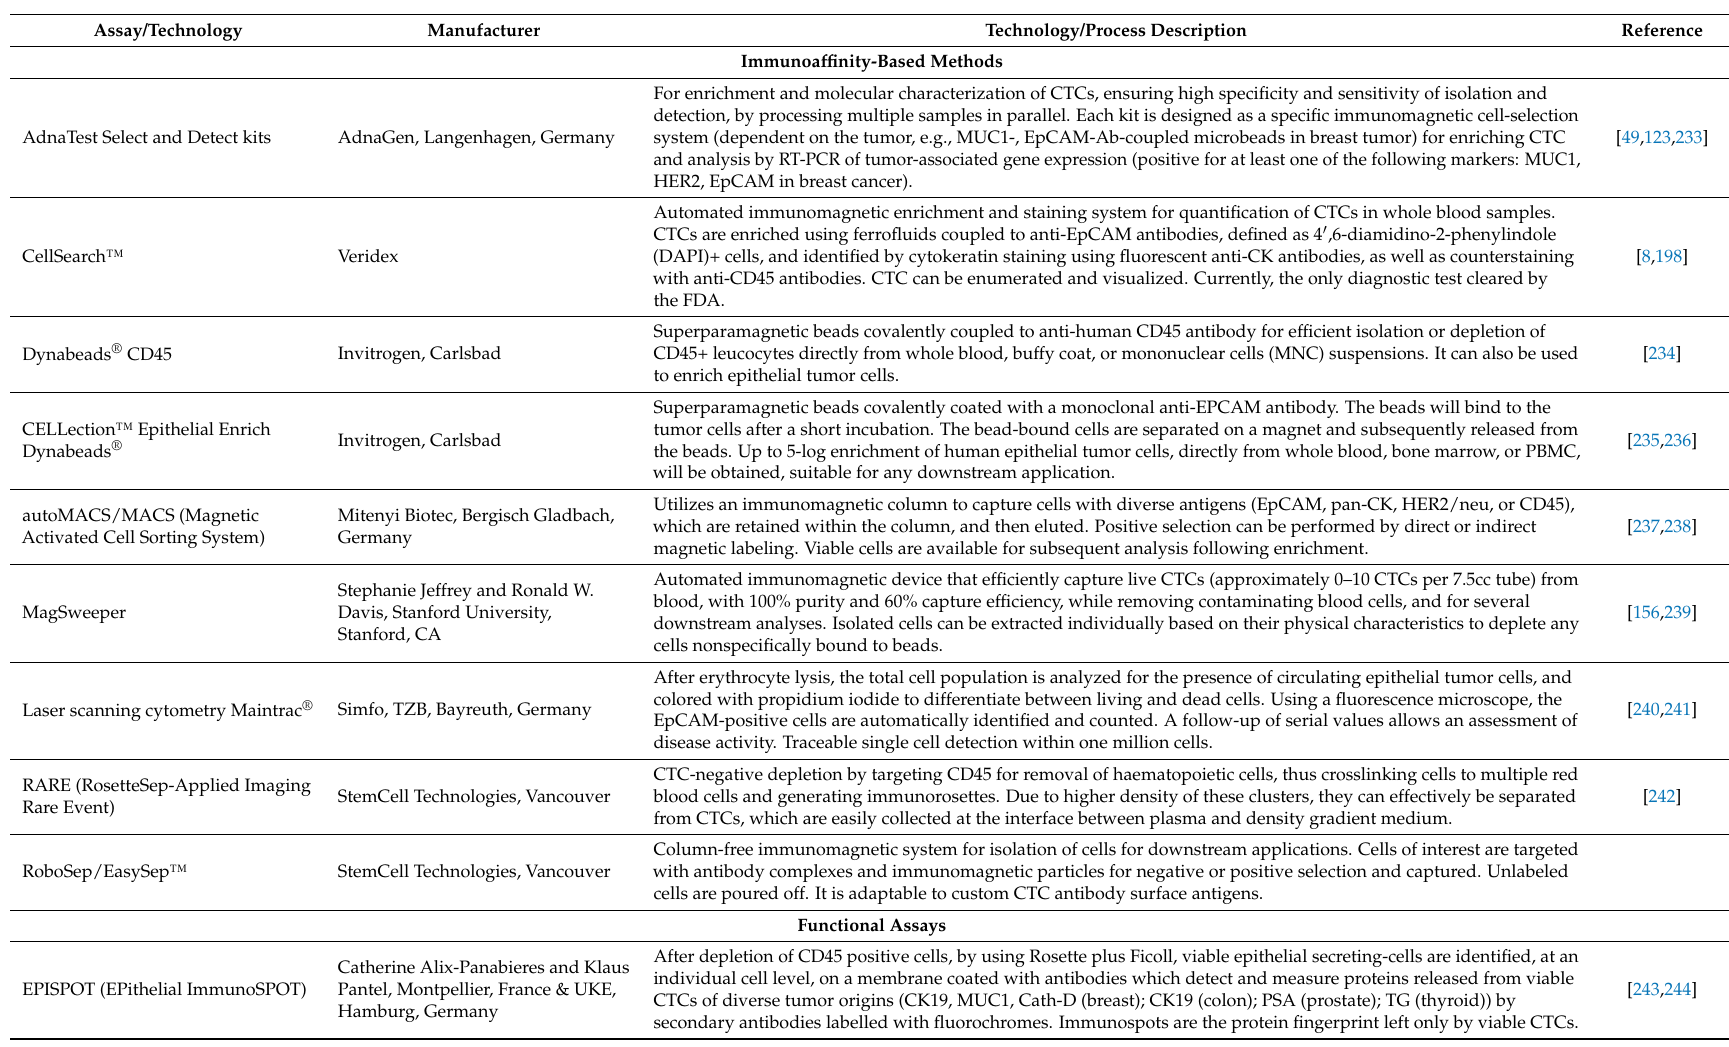
Table 2. List of the current most relevant technologies for CTC detection and characterization for clinical